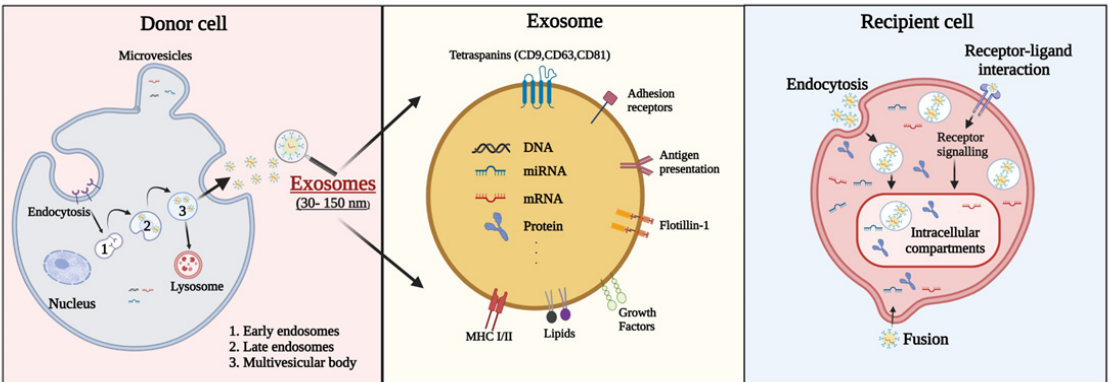
Figure 1. Exosome surface, components of exosome secretion, and interactions between extracellular vesicles (EVs) and recipient cells. EV membrane proteins can be delivered to receptor molecules on the surface of recipient cells, where they trigger signaling cascades. EV membrane proteins can also be cleaved by proteases and converted into soluble fragments that serve as ligands for their cell receptors. EVs can fuse with the membrane of the recipient cell to transfer cargo to the recipient cell. Migrated exosomes can be activated in the recipient cell in several ways. The secreted exosome fuses to the target cell and assists receptor–ligand interaction and endocytosis.